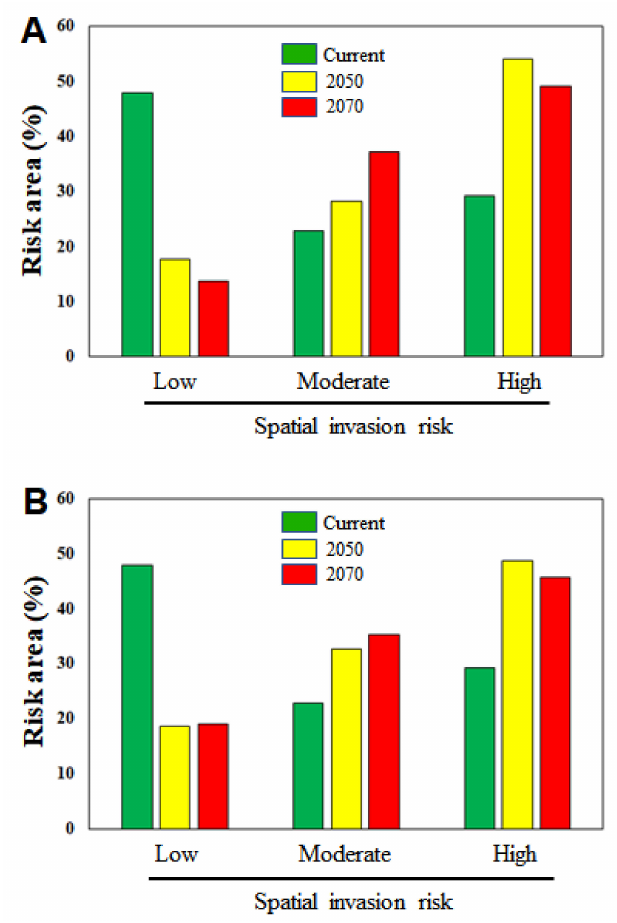
Figure 8. Estimates of the area assigned to different categories of invasion risk relative to the total area of South Korea. The numbers on the y -axis indicate the percentage area categorized as at low, moderate, or high risk of invasion under current and future environmental conditions. ( A ) RCP 4.5 and ( B ) RCP